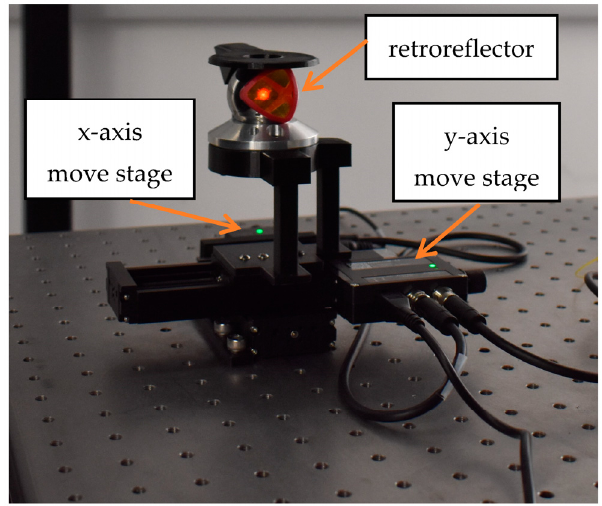
Figure 4. XY-linear move stage.